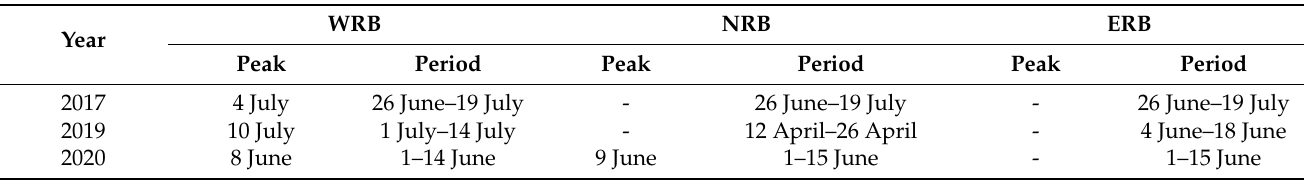
Table 3. Flood peak time and corresponding flood period in West River Basin (WRB), North River Basin (NRB) and East River Basin